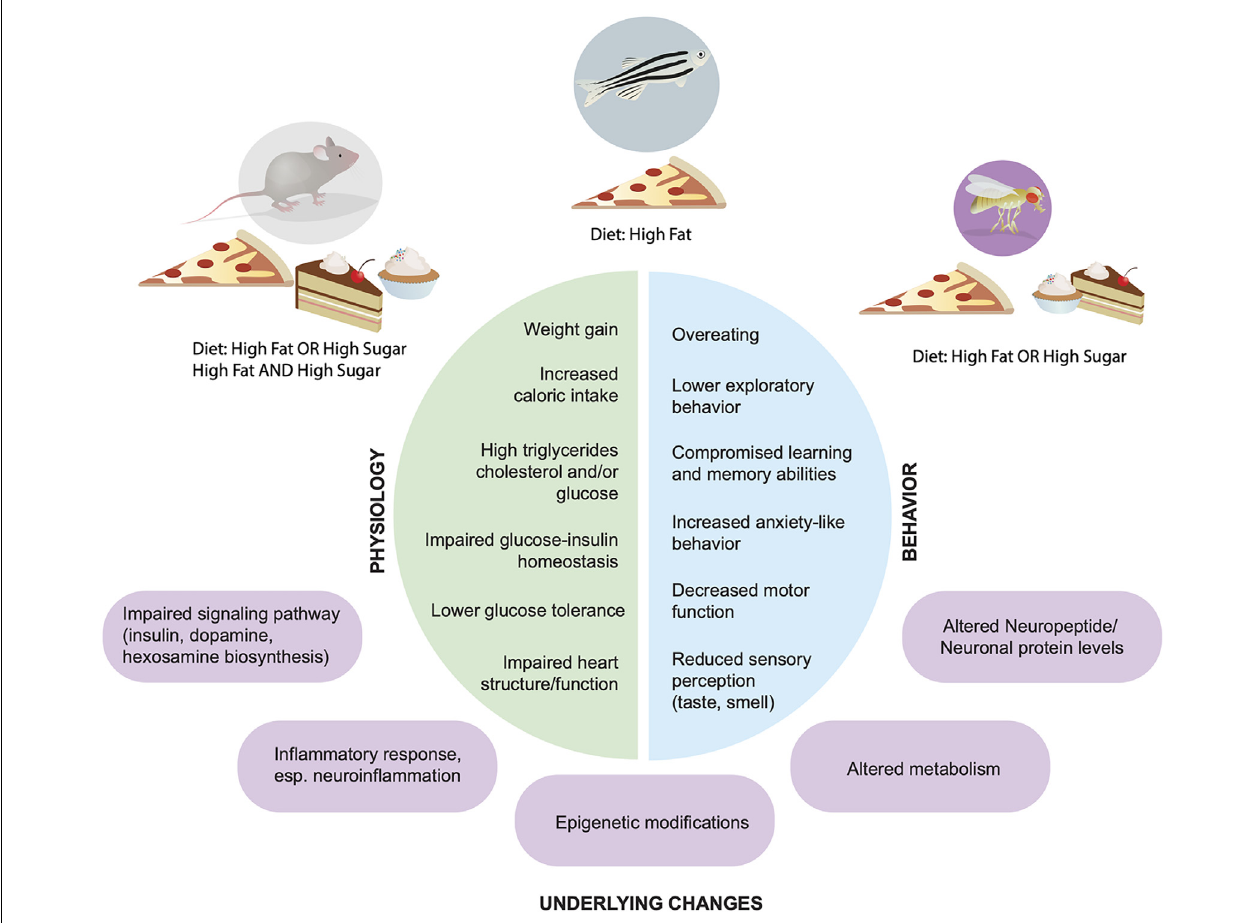
FIGURE 1 | Physiological and behavioral effects of high fat and sugar diets. Across animal models Rattus norvegicus , Mus musculus , Danio rerio , Drosophila melanogaster (top) dietary manipulations lead to alterations in physiology (left, green) and behaviors (blue, right); underlying molecular and cellular mechanisms are shown in